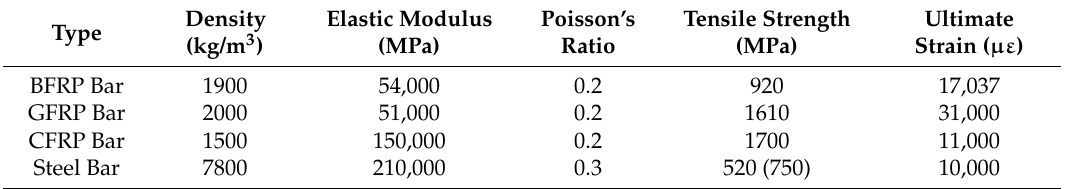
Figure 15. Constitutive relationship of steel reinforcement. Table 3. Material properties of the